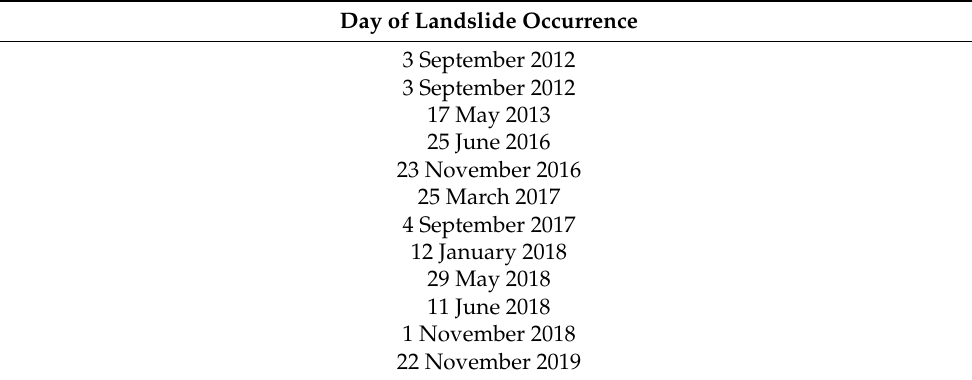
Figure 2. Overview of the rainfall and landslide data collected in the same physiographic setting of Theilly landslide. Table 1. Landslides news used for the calibration.